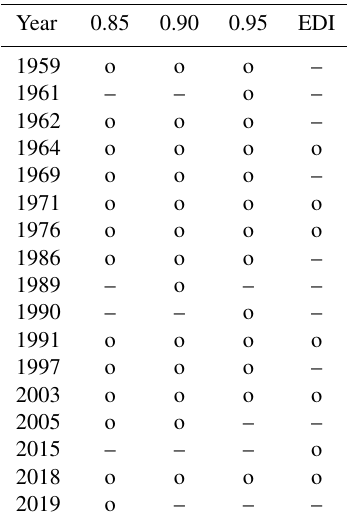
Table 6. As in Table 3 but for drought in the GES region during the SHY.